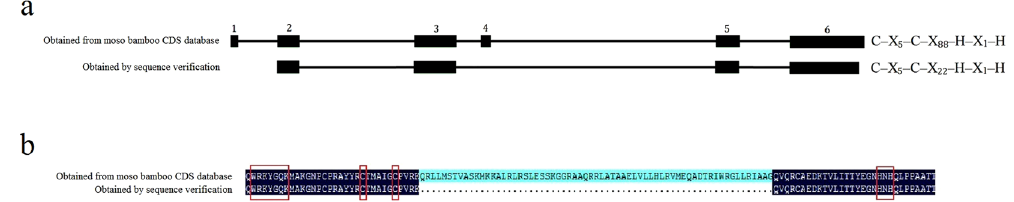
Figure 2. (a) Structure of the PheWRKY9-1 gene. The sequence obtained from the P. edulis CDS database is indicated on top, and the sequence obtained by sequencing verification is shown below the sequence. (b) Sequence alignment of the PheWRKY9-1 sequence obtained from the P. edulis CDS database and the sequence obtained by sequencing